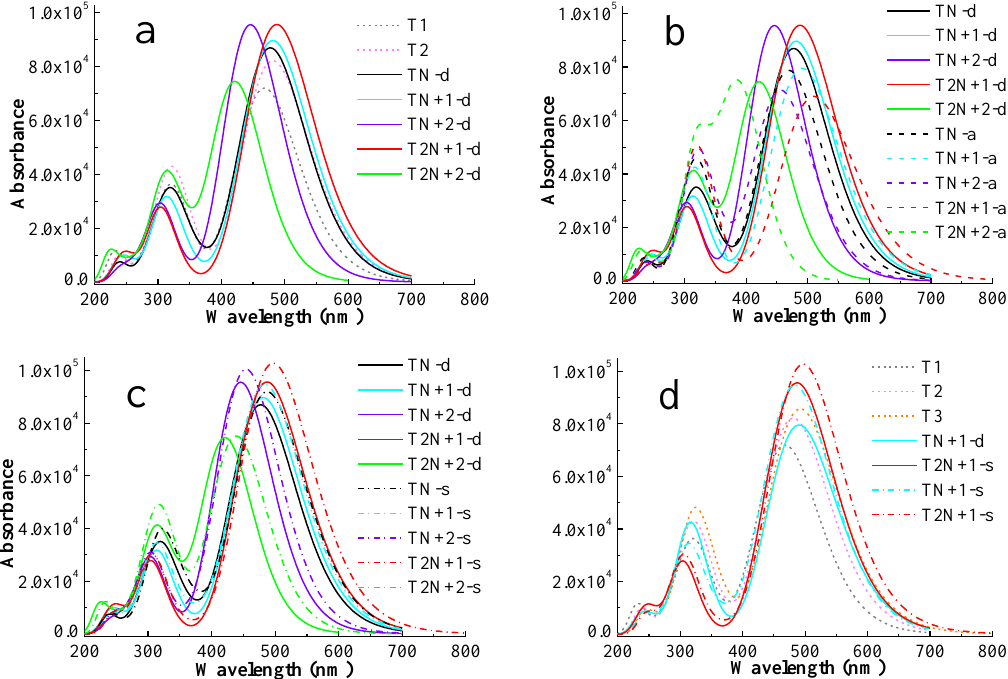
Figure 2. Absorption spectra of dyes. Comparison of T1, T2, and D series ( a ), comparison between D and A series ( b ), comparison between D and S series ( c ), and comparison of the selected dyes and T series ( d ).